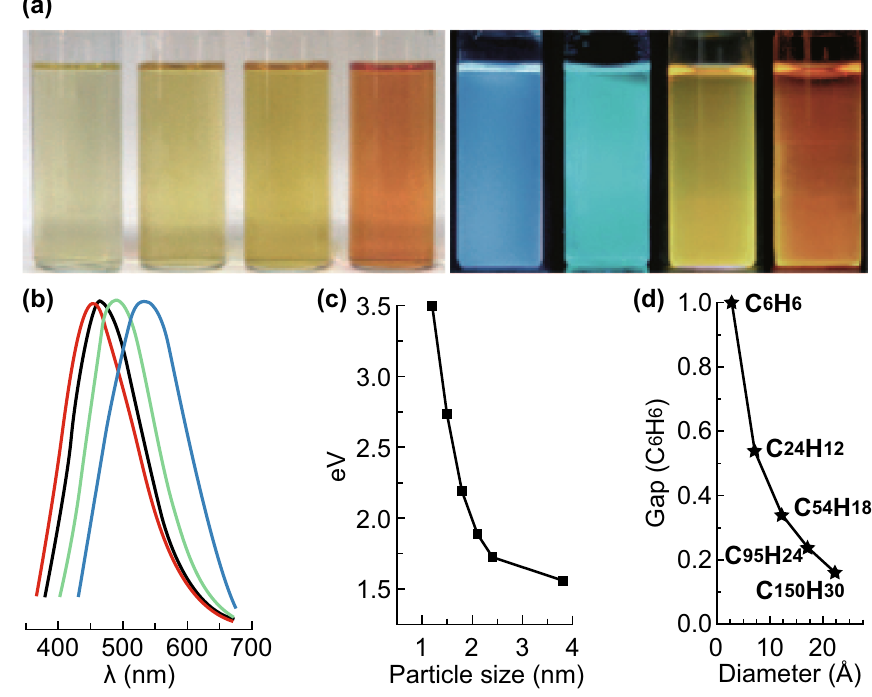
Fig. 9 aPhotographs of CQDs with increasing particle dimensions under (left) white and (right) UV light, b PL spectrum of CQDs with emission from blue to red, c relationship between the CQD particle size and PL properties, and d relationship between the HOMO–LUMO bandgap and the size of the graphite fragments [90]. Copyright (cid:2) 2010 WILEY–VCH Verlag GmbH & Co. KGaA, Weinheim. (Color figure online)